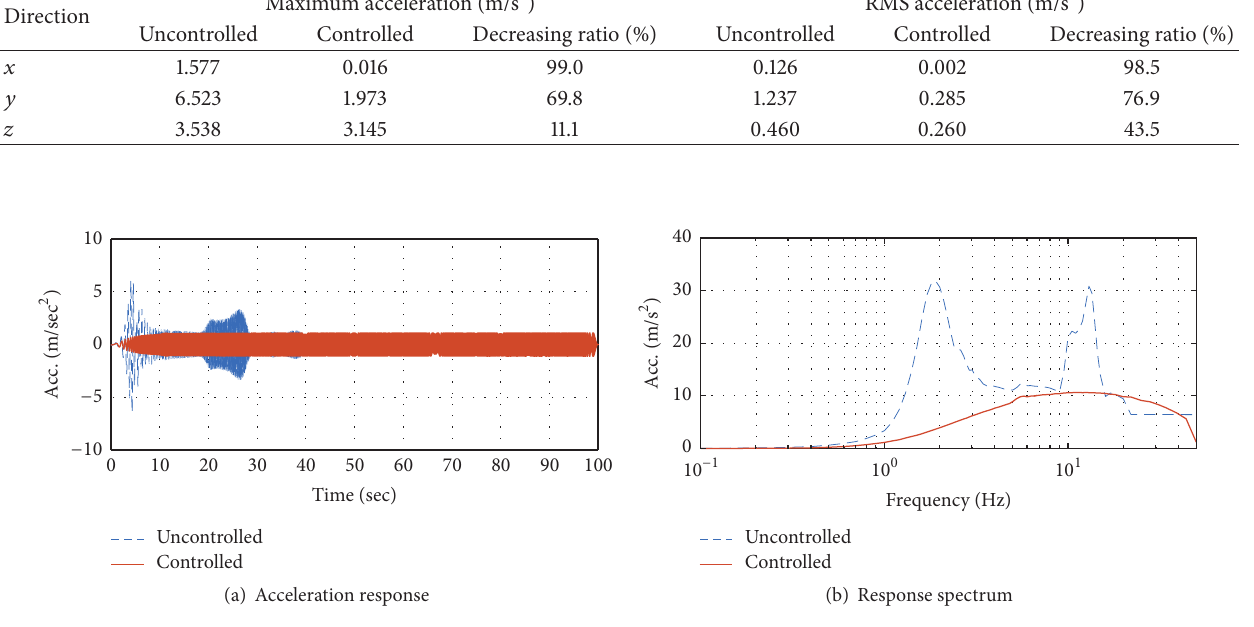
Figure 10: Response of piping system subjected to sine sweep wave ( 𝑦 -direction load and response).